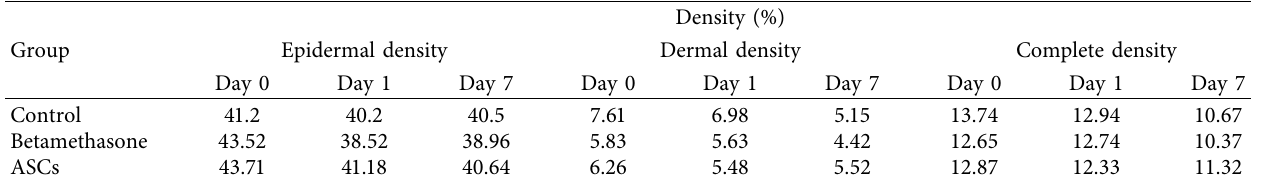
Table 2: Thickness of epidermis, dermis, and complete skin in control, betamethasone, and treatment with ASC extract on days 0, 1, and 7 ( p ≤ 0.05).